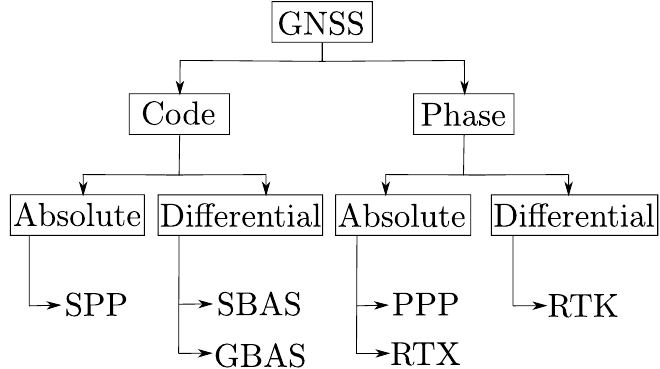
Figure 1. Classification of GNSS